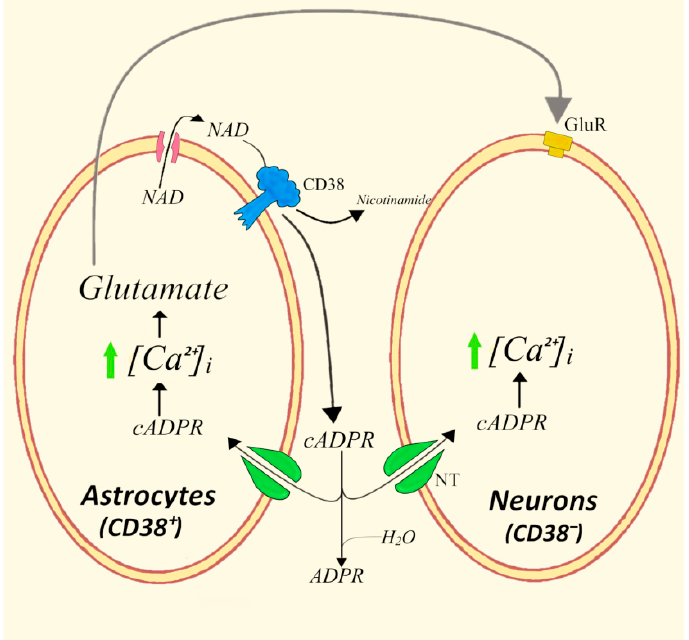
Figure 5. Paracrine/autocrine roles of NAD + /cADPR and glutamate in eliciting Ca 2+ responses in astrocytes and neurons. GluR, Glutamate receptor; NT, nucleoside transporters.